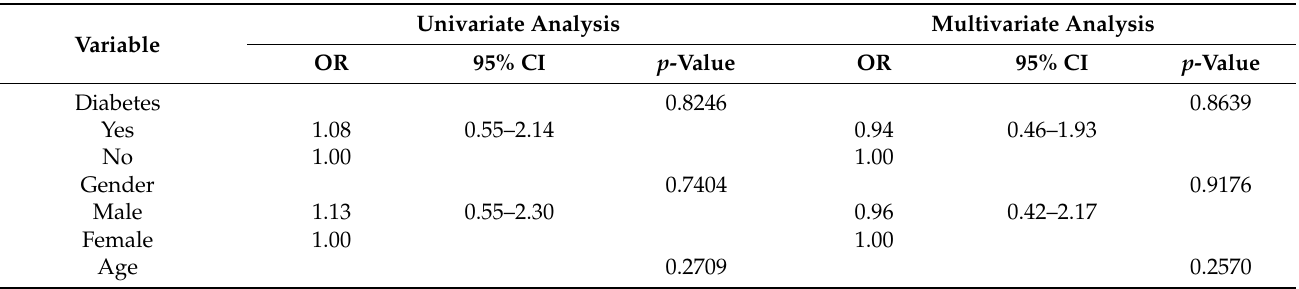
Table 3. Logistic regression analysis result (rehospitalization due to ACS or stroke within 1 year as the response